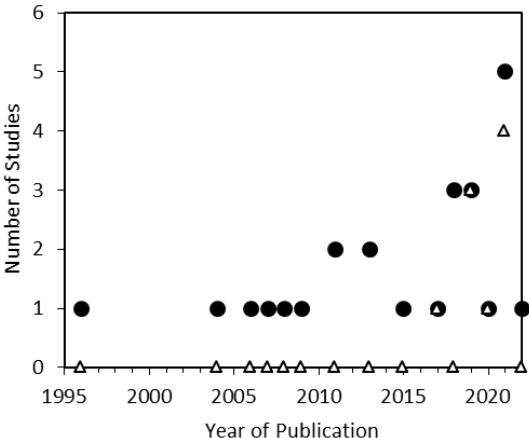
Figure 2. Number of reviewed studies per year (filled cycle), and number of reviewed studies where Raman and SEM-EBSD methods were used (open triangle). The search was carried out on 5 April 2022.